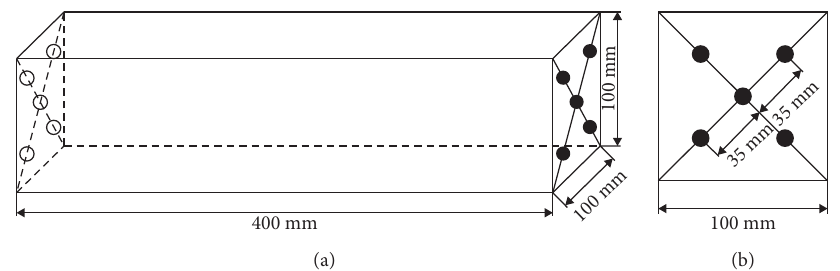
Figure 5: Measurement points used in the ultrasonic wave velocity test. (a) Layout of measurement points. (b) Front view of measurement